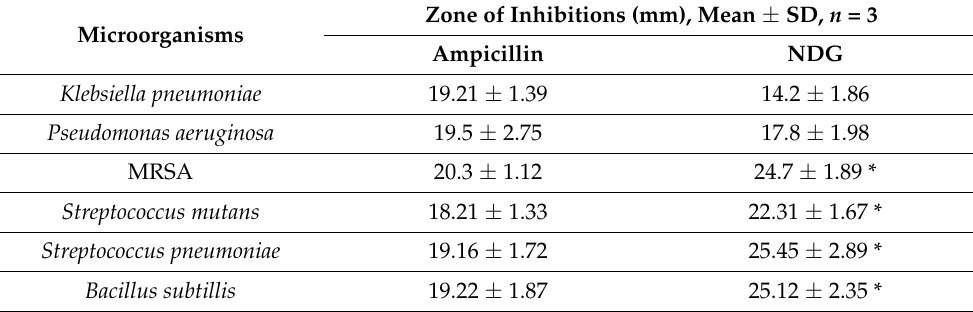
Table 1. Zone of inhibitions obtained during agar diffusion test by NDG as compared to ampicillin. Results were presented as mean ± SD, n = 3.